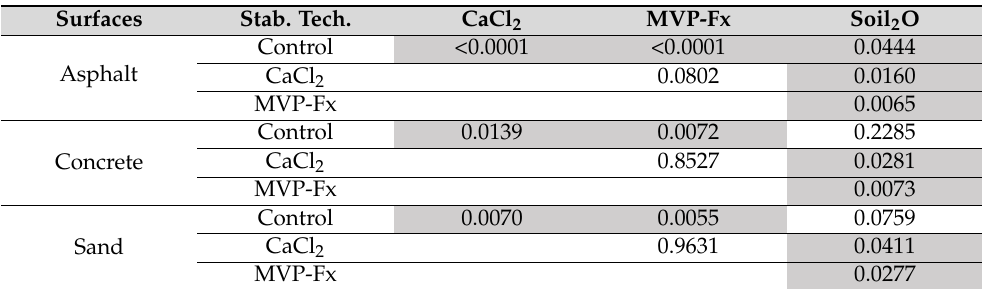
indicates a significant difference ( p <